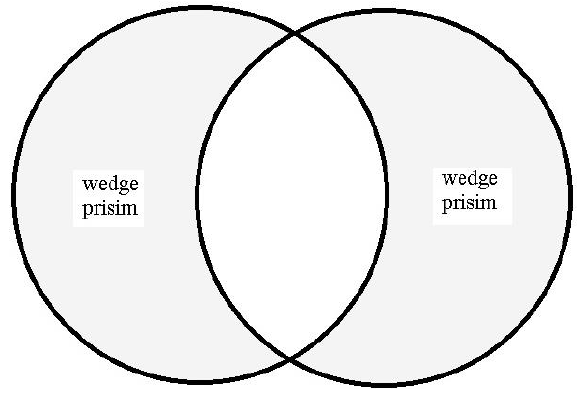
Figure 7. Sketch of the receiver sub-apertures.